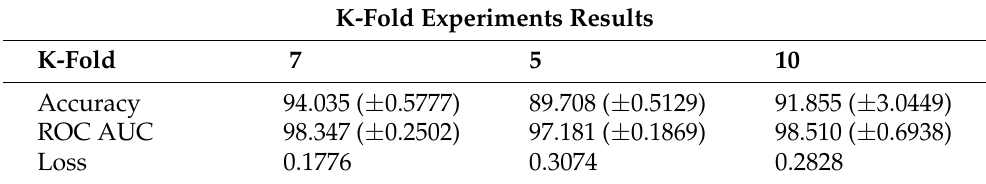
Table 1. Experimental results with different